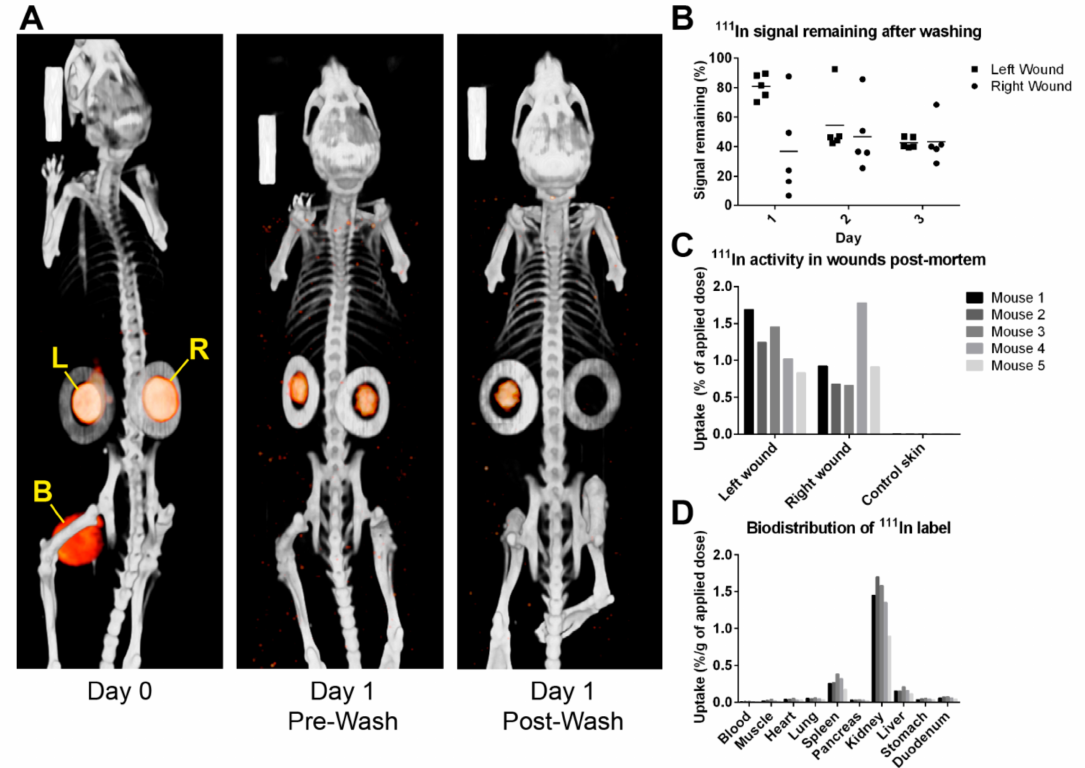
Figure 1. [ 111 In]In-DTPA-PIC gels applied to splinted wounds were tracked by SPECT/CT imaging before and after washing. ( A ) SPECT/CT scans show the orange signal (SPECT) originating from PIC gel within the circular-shaped splints (greyscale CT signal) of the left wound (L) and right wound (R). After washing (on day 1), the SPECT signals in the wounds decrease. In the left wound, the signal becomes visually lower, while the signal from the right wound is so low that it is no longer visible after image processing. The large signal source between the hind legs on the day 0 scan originates from 111 In-bound EDTA in the bladder (yellow B). ( B ) This dot plot indicates the amount of 111 In signal remaining in the wound areas after washing via different methods (see text), as quantified from SPECT/CT scans. Horizontal bars represent mean signal remaining. ( C , D ) Post-mortem activity measurements still show high activity in the wounds, the kidneys, and a small amount in the spleen and liver. Activity in wounds was expressed as a percentage of the applied dose instead of the applied dose per gram of weight because samples were too light to weigh